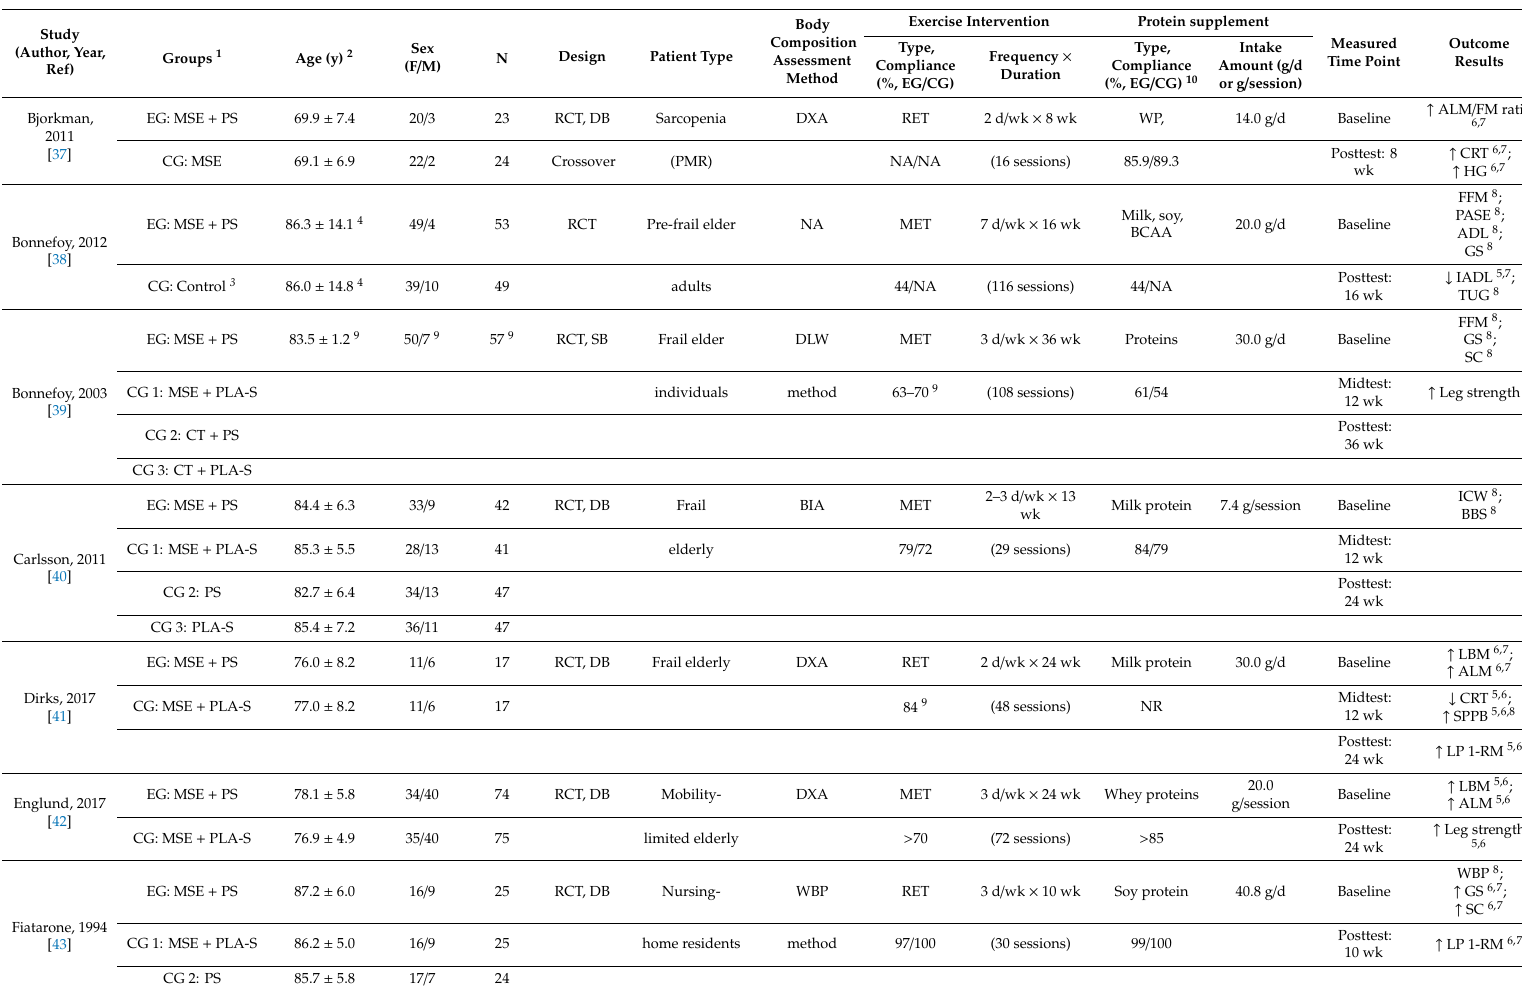
Table 1. Summary of included study